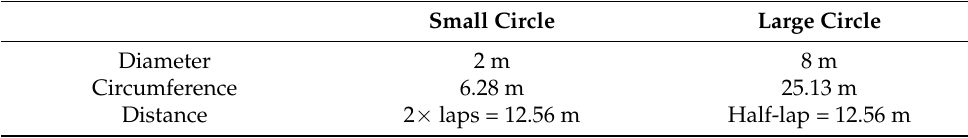
Table 1. Dimensions of the small and large